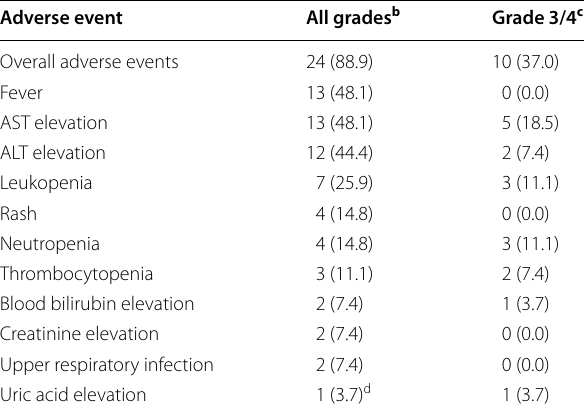
Table 3 Incidences of treatment-related adverse events a after single-agent CPT treatment in 27 patients